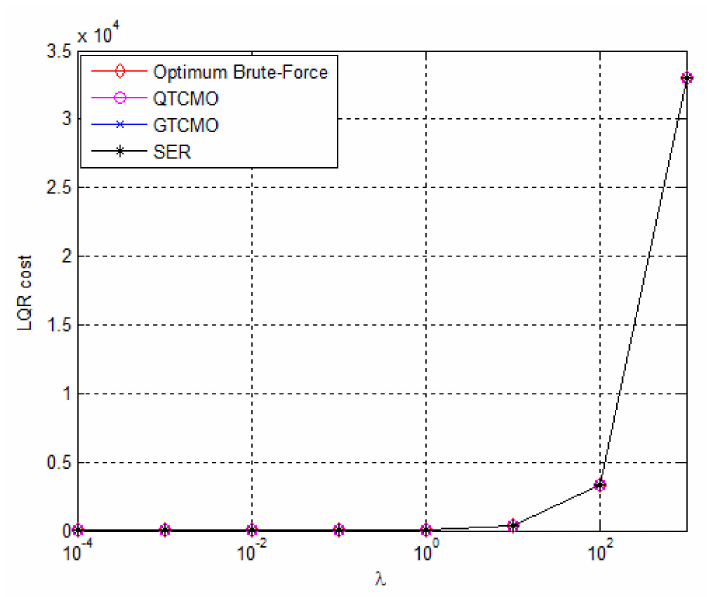
Figure 5. The LQR cost of the proposed algorithm for λ .